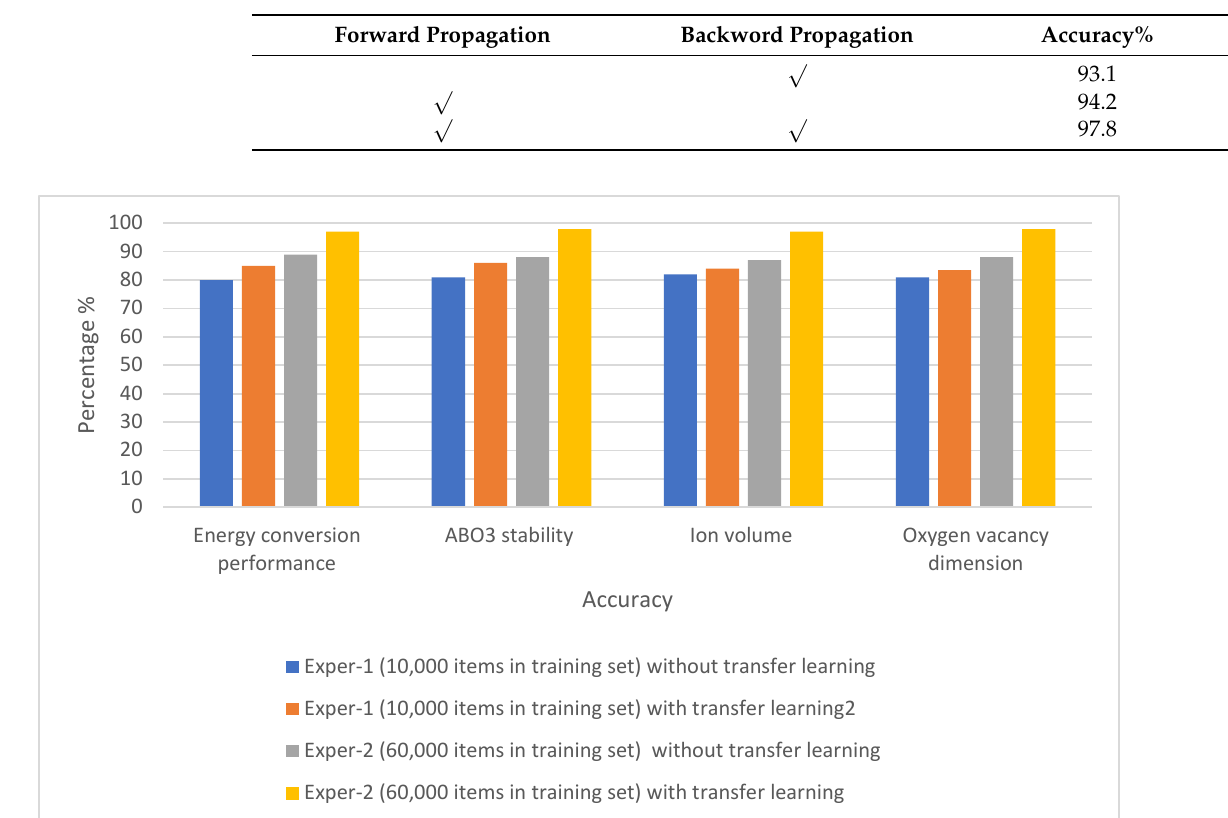
Figure 10. Classification accuracy rate for the four output LSCD classes.